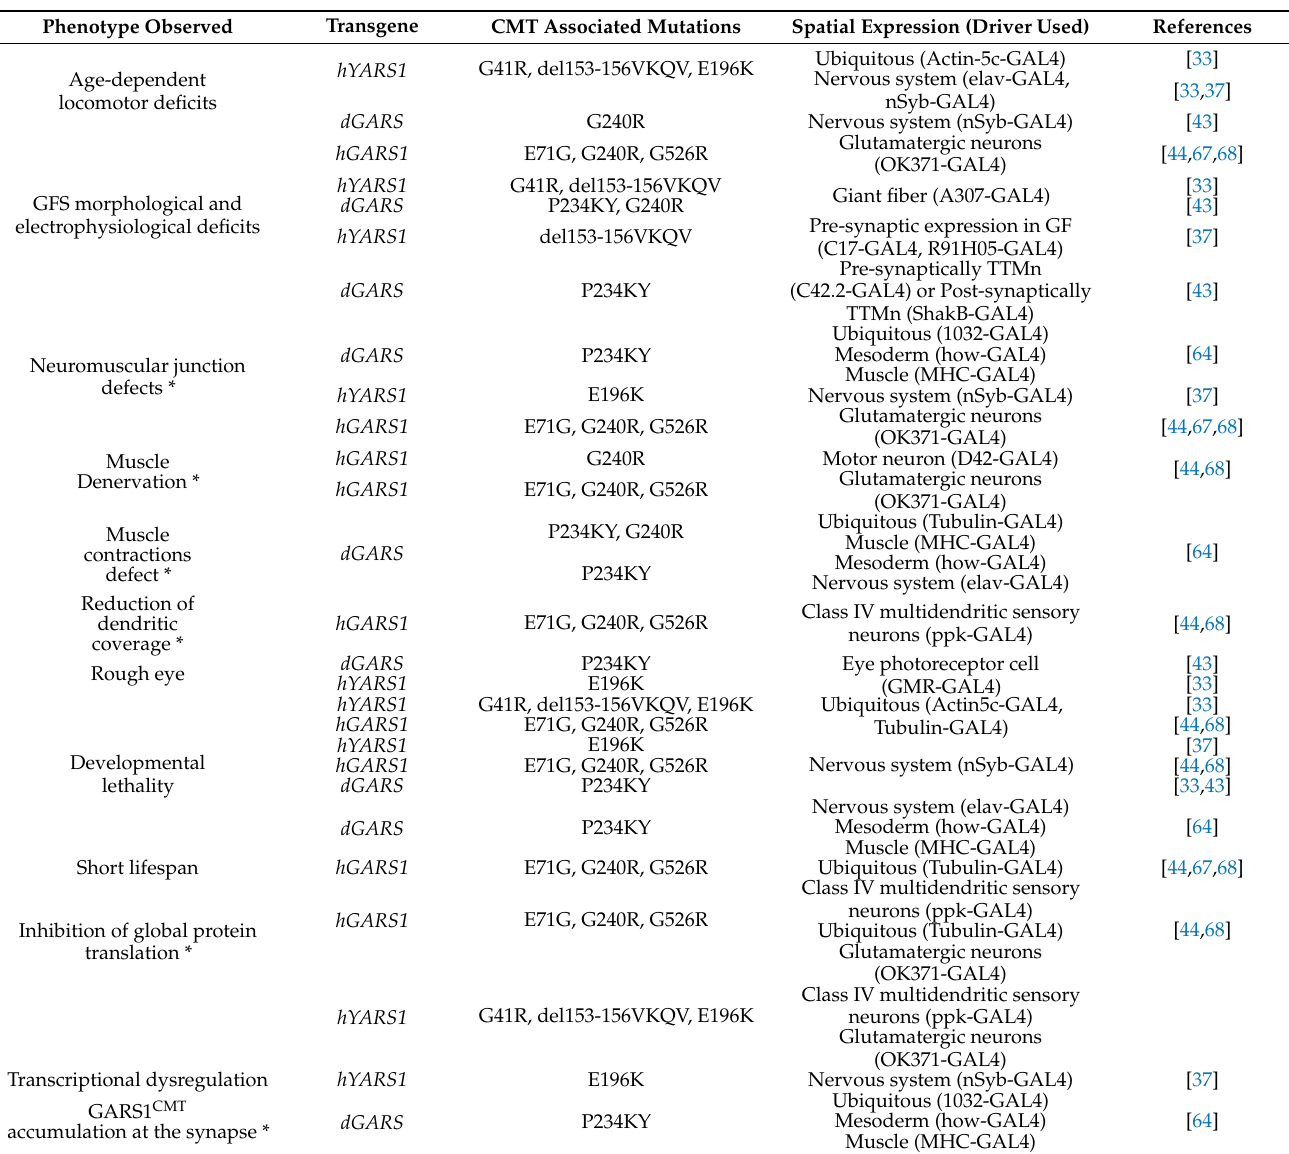
Table 3. Differential spatial expression of CMT-causing mutations using specific GAL4-drivers results in similar CMT-like phenotypes in both YARS1 CMT and GARS1 CMT D. melanogaster